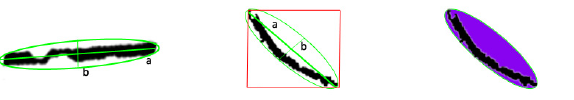
Figure 3: Comparison of bounding ellipses with bounding box method for straight (left) and curved road components (centre); the area of bounding ellipse in lilac compared to the area of the road component in black(right)